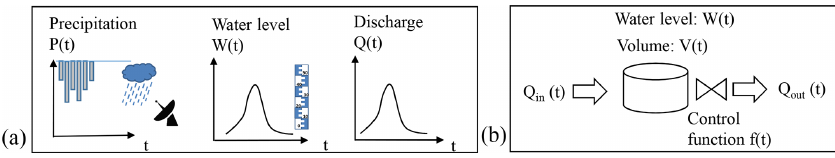
Figure 1. (a) Illustration of operative criteria in a control function depending on driver time series of precipitation, water level and discharge. (b) Scheme of a control structure with a control function changing the water level W(t) , volume V(t) or outflow Q(t) per time step t